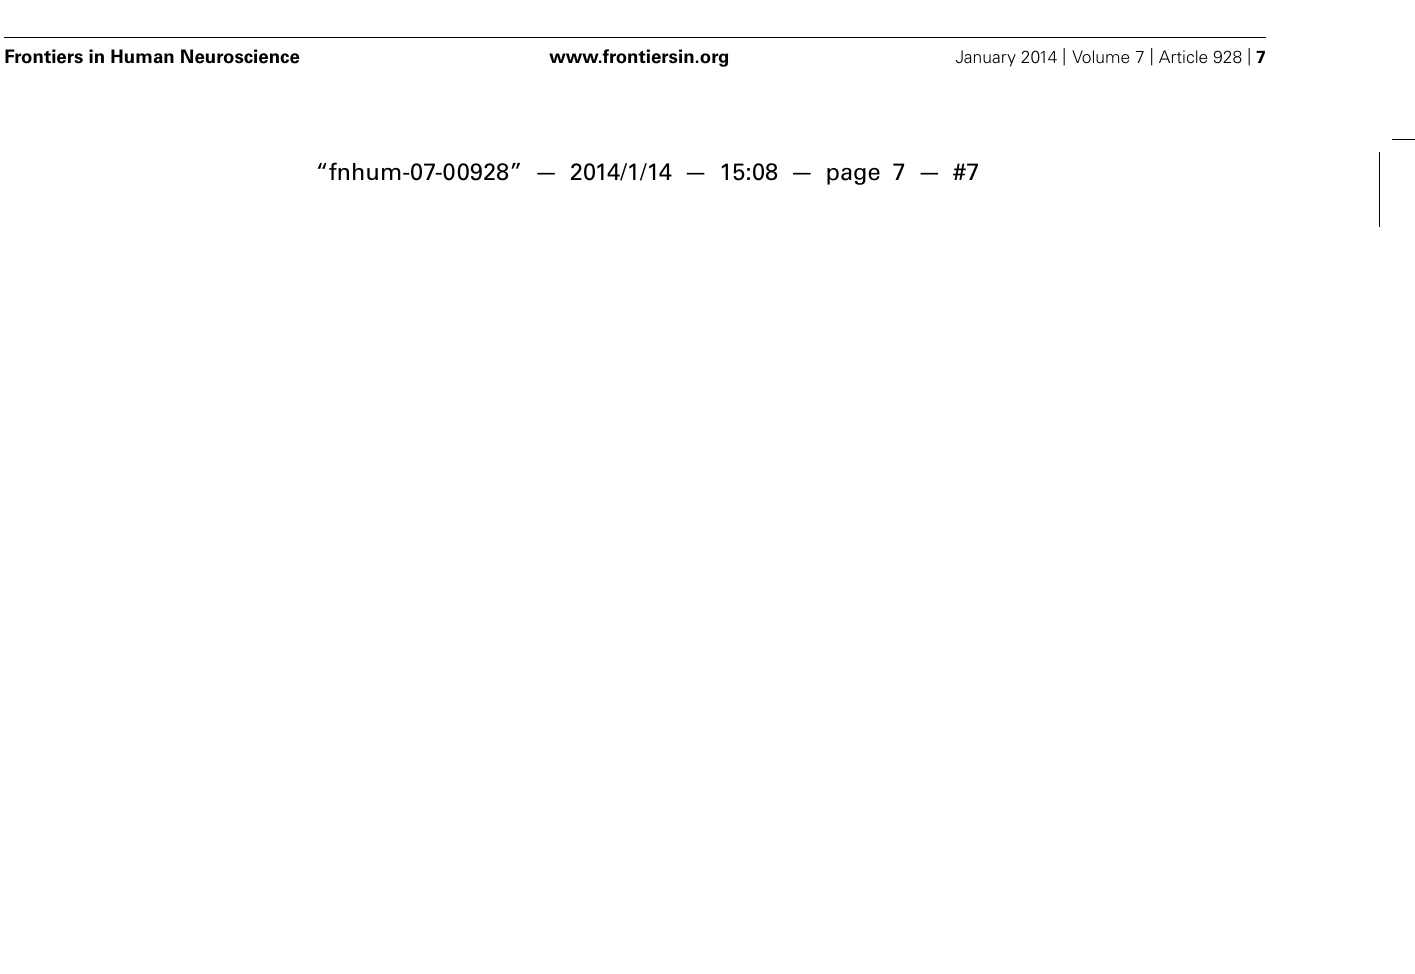
p = 0.472, Figure 4B ]. Baseline amplitude variation did not dif- fer between PD patients and controls [independent sample t